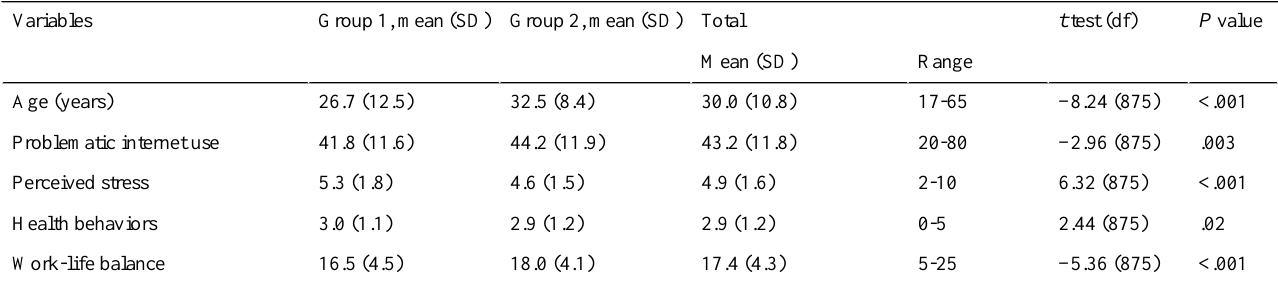
Table 1. Descriptive statistics of main study variables in the 2 groups (N=877; group 1: residents in Germany and group 2: residents in China).